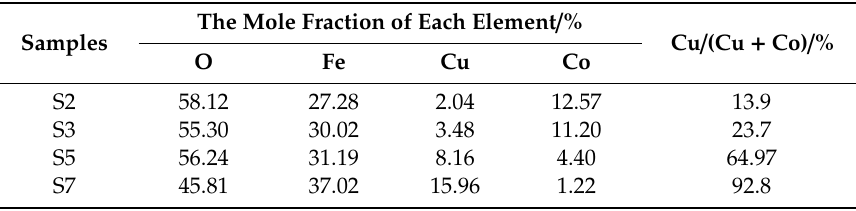
Figure 2. SEM images of samples S2 ( a ), S3 ( b ), S5 ( c ) and S7 ( d ). Table 2. EDS result of samples S2, S3, S5 and S7 and the mole ratios of Cu / (Cu + Co).